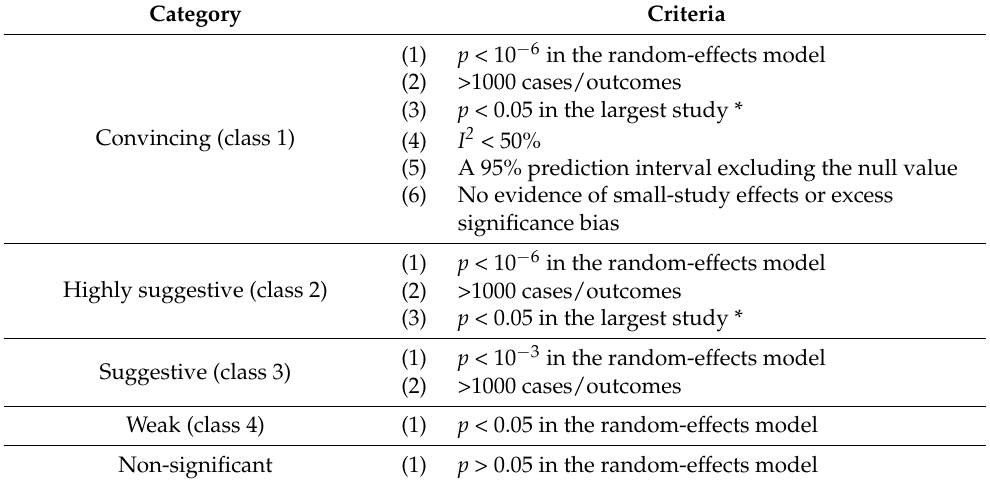
Table 1. Criteria for quality-of-evidence